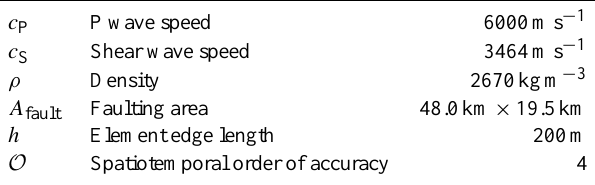
Table 2. Simulation parameters for SCEC test case TPV17.